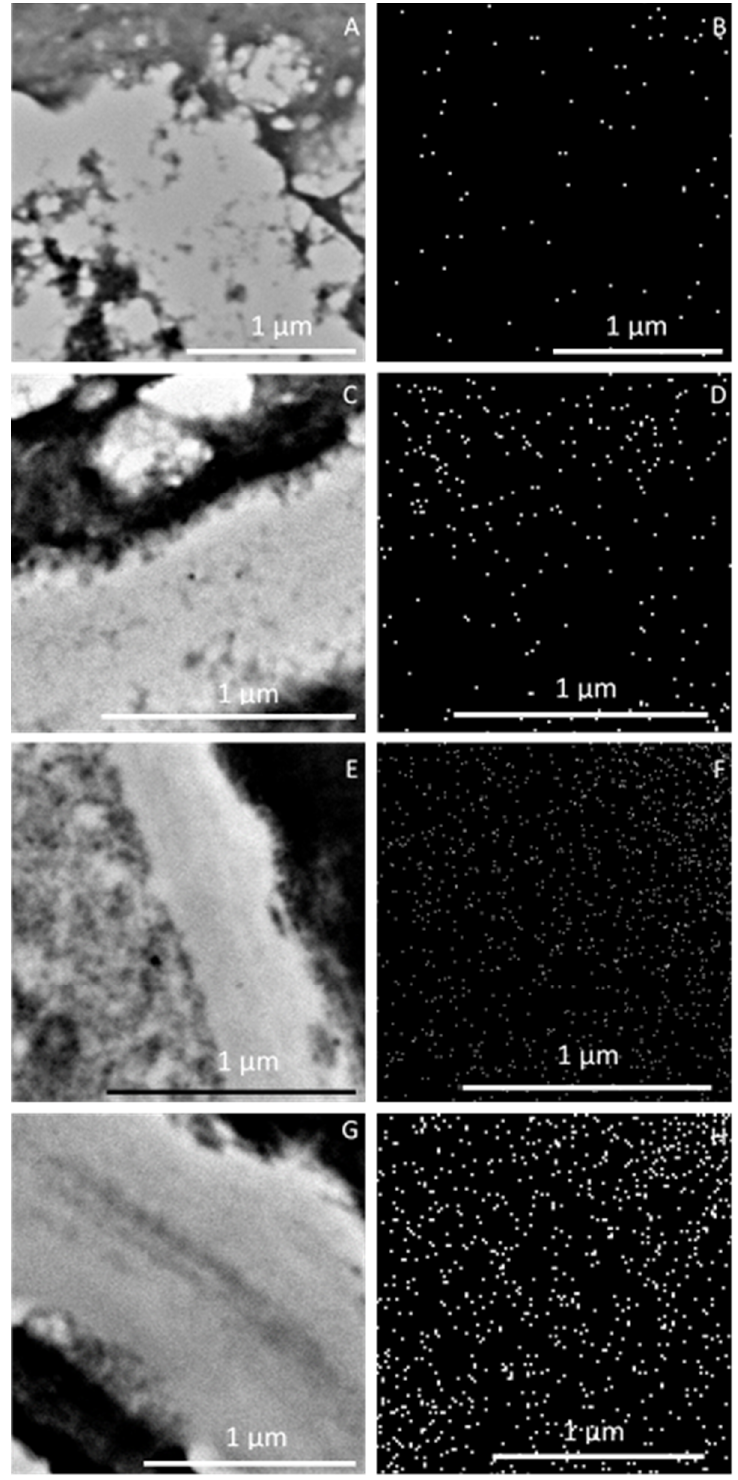
Figure 10. A – H . Fragments of epidermis cells ( A , C , E , G ) and mapping Ca 2 + cations in the section ( B , D , F , H ) including the cell wall, plasmalemma, and cytoplasm from the apical part of ‘Szampion’ apples from the control treatment ( A , B ) and the Ca(NO 3 ) 2 ( C , D ), CaCl 2 ( E , F ), and EDTA-chelated Ca ( G , H ) foliar feeding variants. A,C,E,G—TEM, B,D,F,H—EDS INCA Energy TEM.